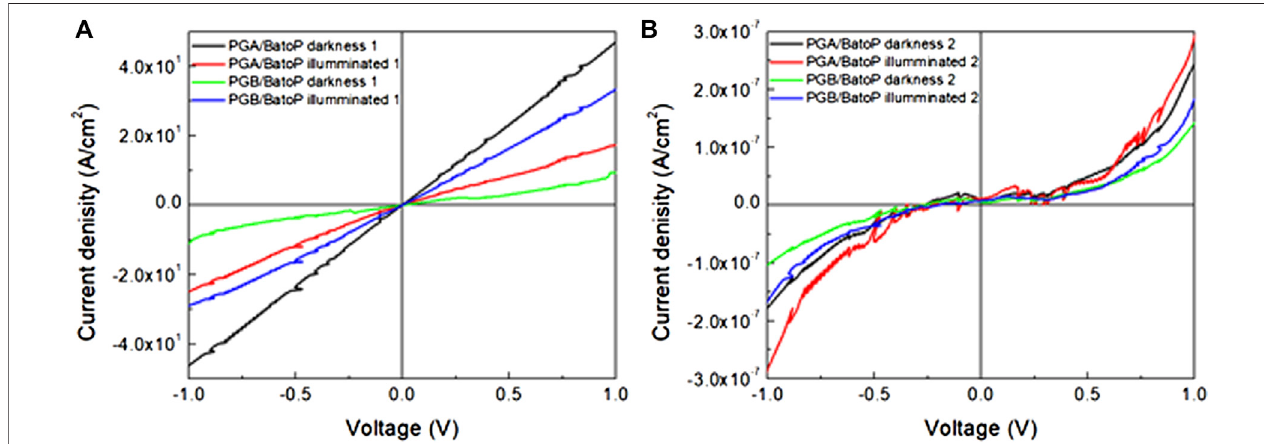
FIGURE 11 | Comparison chart of the darkness and illumination conductivity for (A) PEDOT:PSS-graphene- a and (B) PEDOT:PSS-graphene- b devices, after adding BPhen and irradiating for 2 and 4 h.